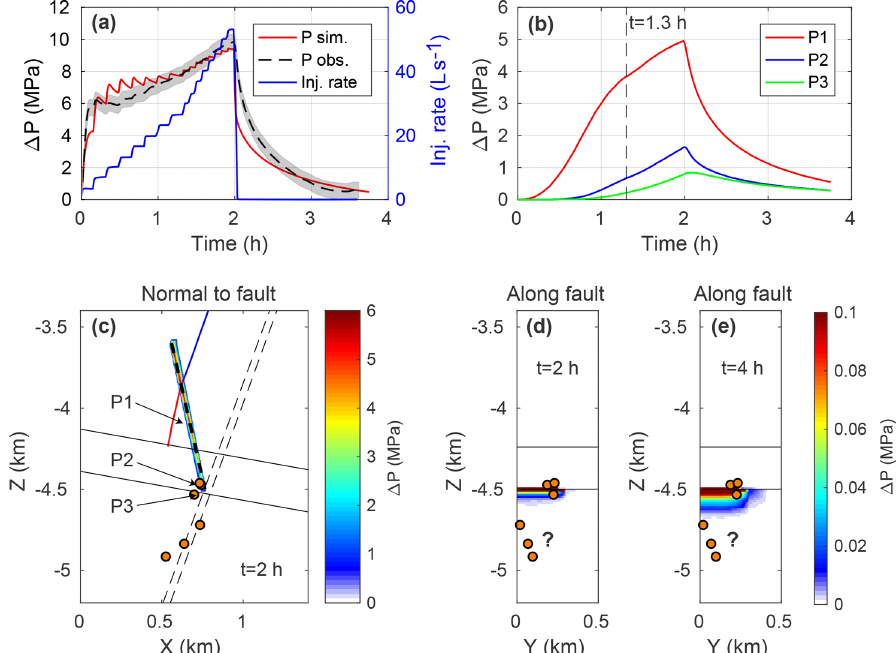
Figure 7. Simulated pressure change during the injection test. (a) Comparison of the measured and simulated pressure at the open section of the well after the model calibration with iTOUGH2-PEST. The shaded area denotes an error bound of 0.5MPa of the measured pressure. (b) Pressure change over time at different points marked in (c) : P1 in the fracture zone at a depth of ca. 4.2km, P2 at the fracture zone/fault intersection in the fracture zone, and P3 at the fracture zone/fault intersection in the fault. The dashed black line marks the onset of seismicity at about 1.3h. (c) Pressure change after 2h at y = 0km (along profile A–A (cid:48) in Fig. 2). The well is denoted by the red (open section) and blue (cased section) lines. The orange dots are the projections of the relocated events recorded during the injection test. (d–e) Pressure change after (d) 2 and (e) ca. 4h along the fault (left damage zone, along profile B (cid:48) –B in Fig. 2). The orange dots are the projections of the relocated events recorded during the injection test. The location of the three deeper events is probably an artifact that can be corrected taking into account a local v p /v s velocity anomaly (Diehl et al.,